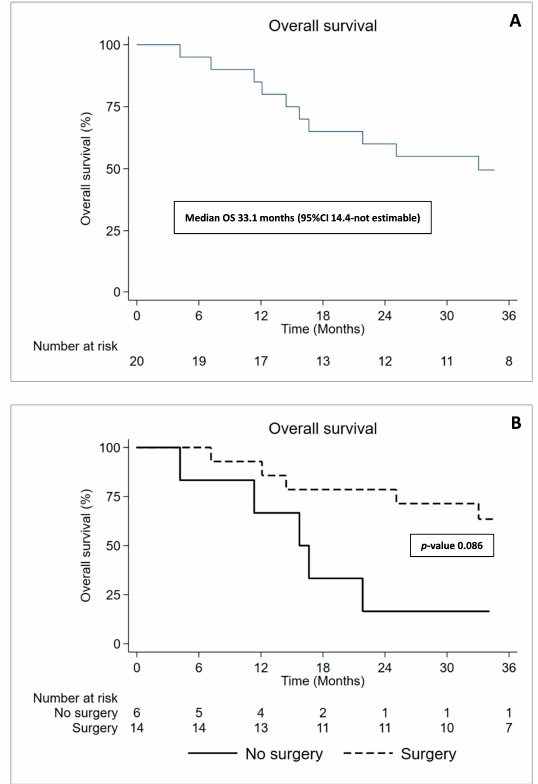
Figure 2. ( A ) Kaplan–Meier curves of Overall Survival for all patients; ( B ) Kaplan–Meier curves for Overall Survival difference between Surgery (P/D) and No Surgery (biopsy only). A